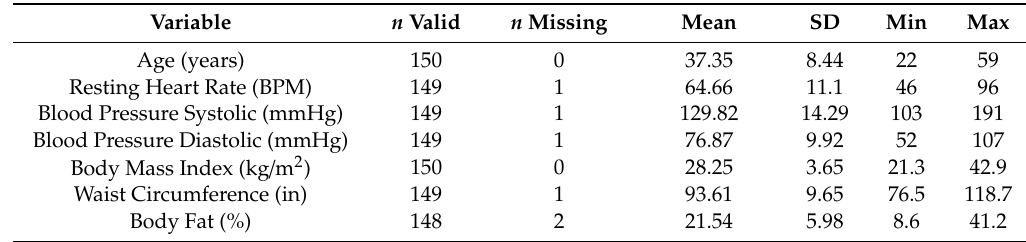
Table 1. Demographic characteristics of